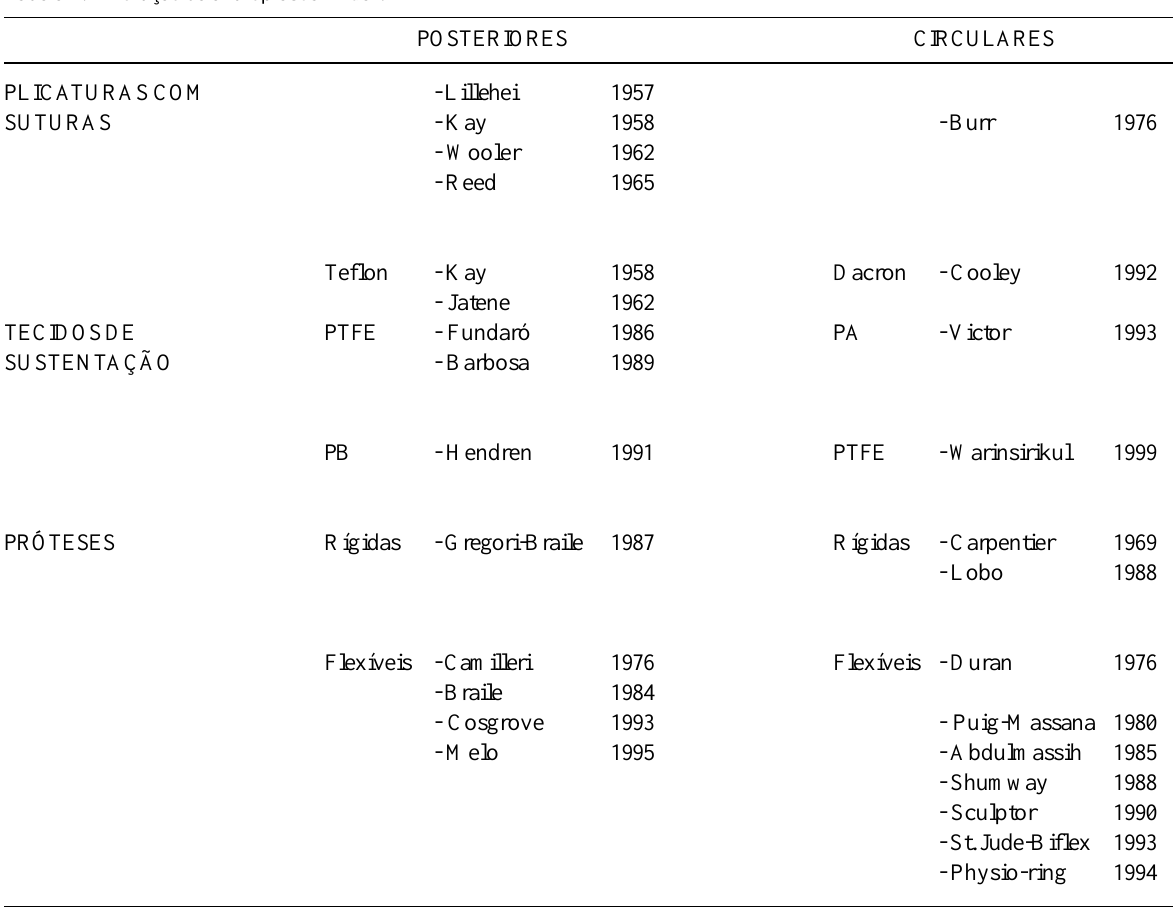
Tabela 1. Evolução da anuloplastia mitral.